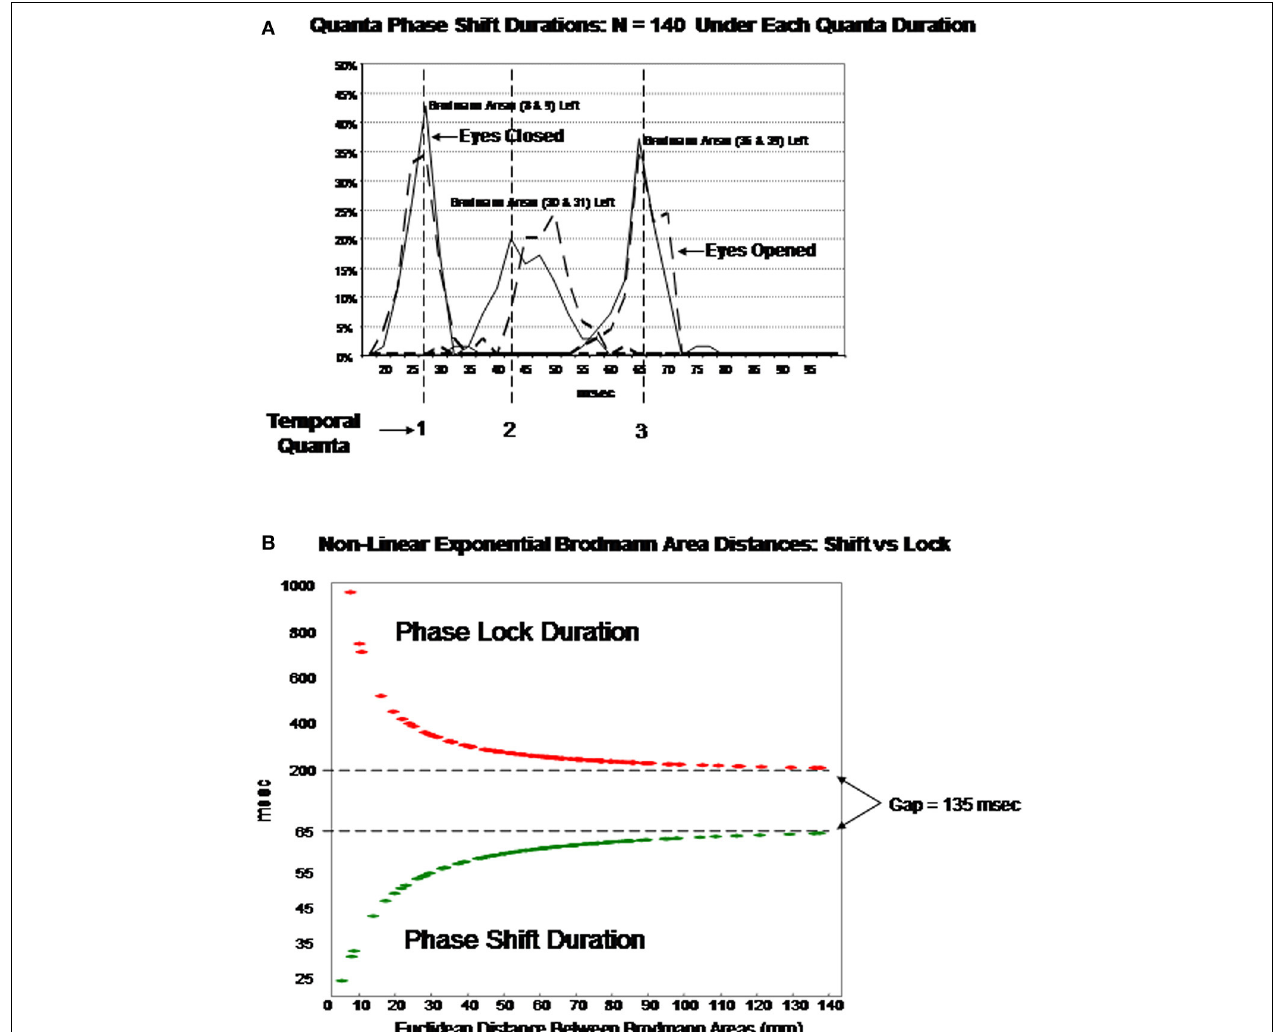
FIGURE 7 | (A) (Top) is an example of discrete durations or “temporal quanta” of phase shift duration in different Brodmann areas of the DMN. The eyes vs. eyes closed shift to longer durations are due to increased functional connectivity with increased input that is like a “shutter” whose duration is proportional to the number of recruited neurons. The discontinuities are due to different packing densities in different Brodmann areas. The bottom plot (B) is the evaluation of Equation (1) using the mean LORETA phase shift and lock duration for both eyes closed and open conditions for the 91 Brodmann area combinations: T = b 1 + e b 2 + ( b 3 / d ) The link between EEG phase shift and neural packing density is the physiological observation of action potential bursts when in-phase to LFPs vs. suppression of action potentials when ant-phase to LFPs Hughes and Crunelli (2007). EEG is the summation of LFPs therefore phase shifts are necessarily related to neural packing density, i.e., the higher the packing density than the longer the phase shift as a property of summation. It is hypothesized that the increased shift duration